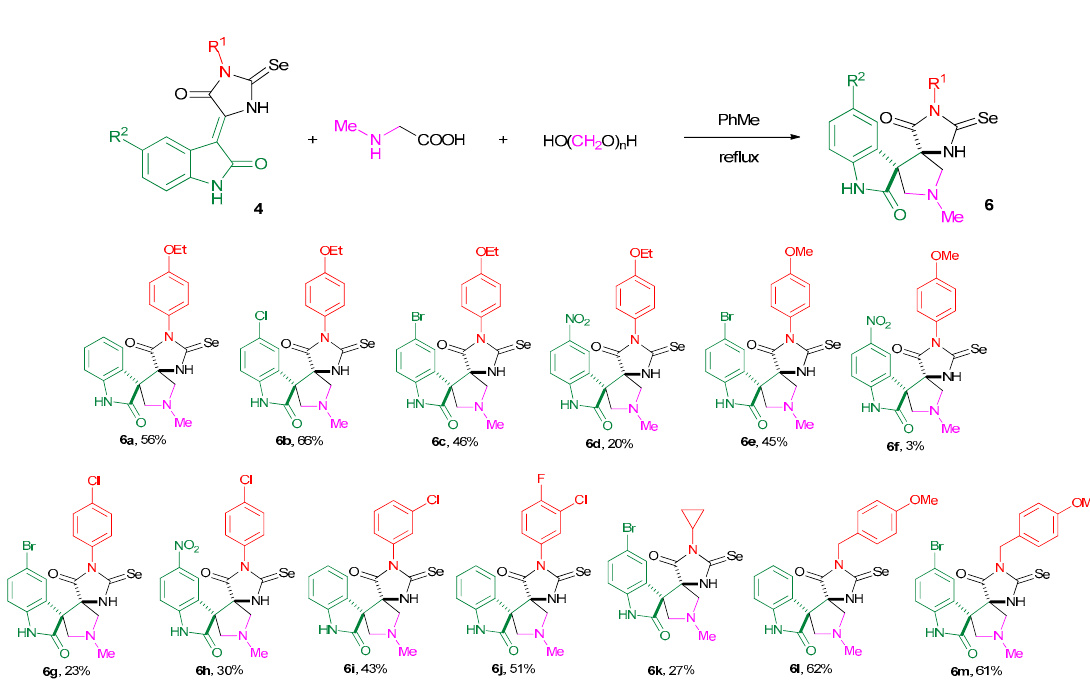
Scheme 5. Synthesis of dispiroselenohydantoins 6 .